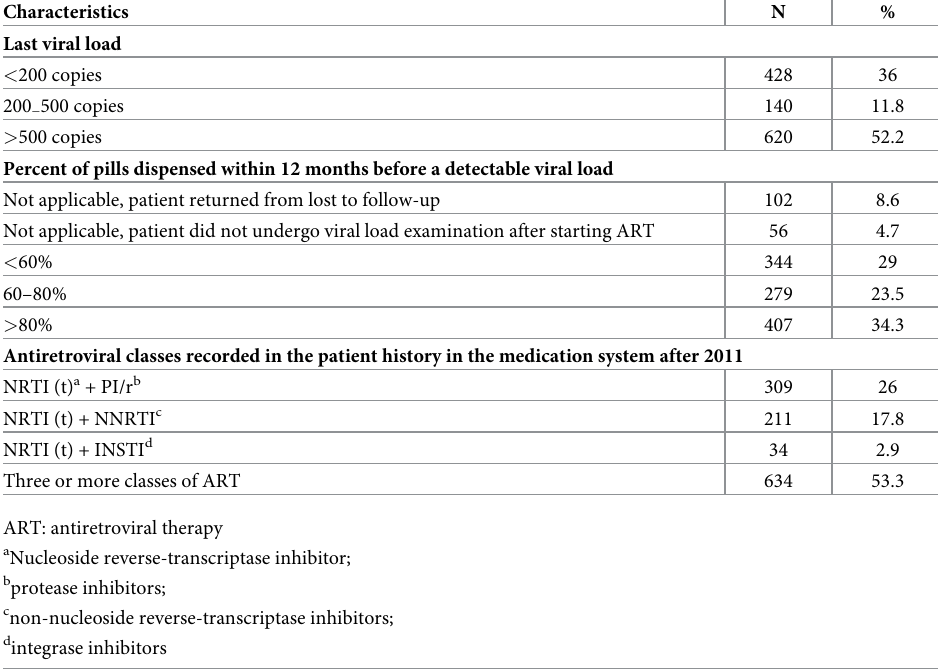
Table 3. Characteristics of patients with virologic failure (n =